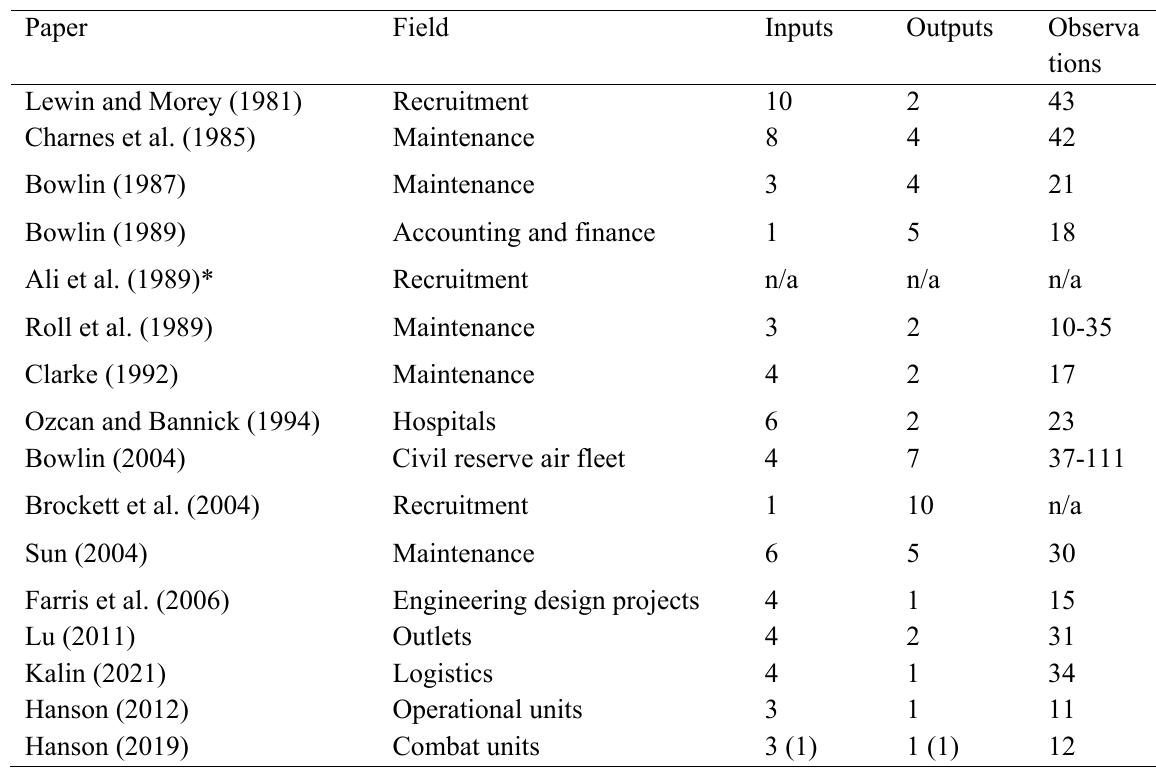
Table 2. Bibliography of DEA in the military